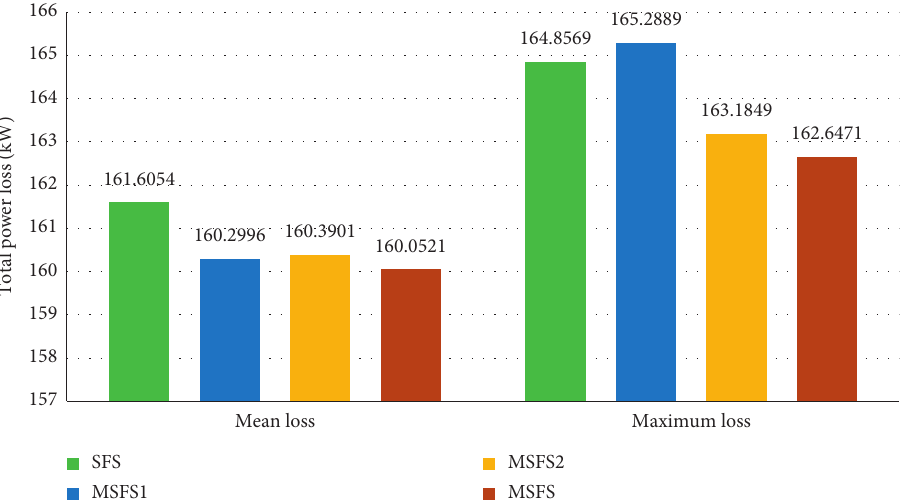
Figure 20: Mean and maximum power loss of 50 trial runs obtained by SFS methods for case 1 of the 85-bus